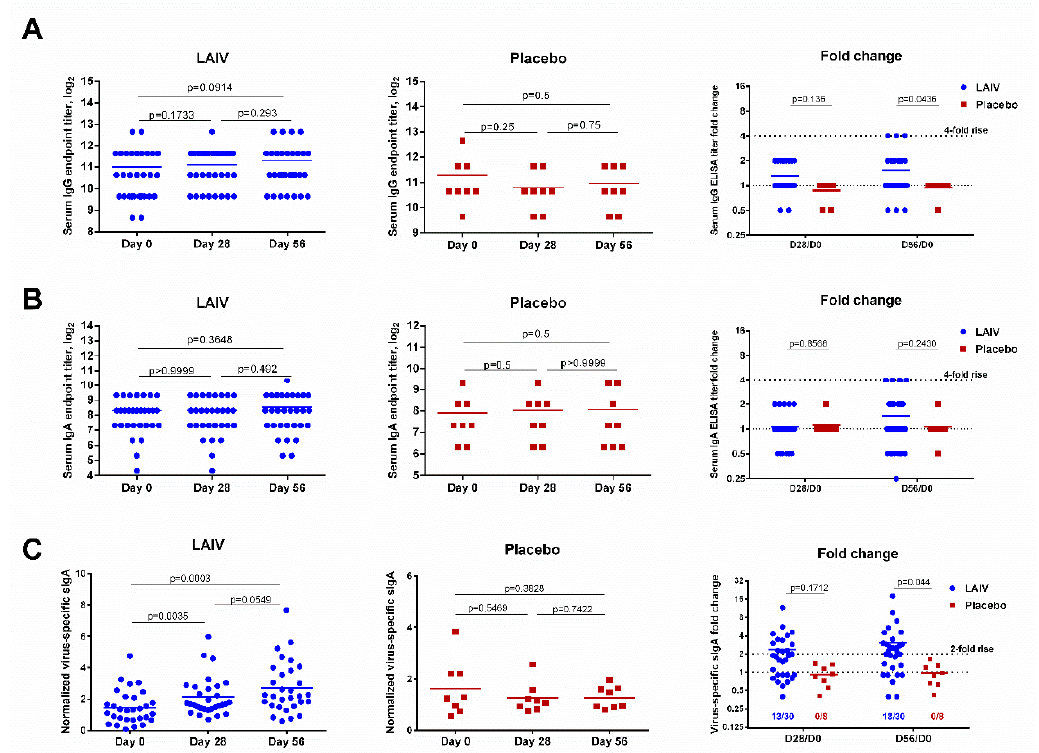
Figure 3. Virus-specific serum IgG and IgA antibody titers and nasal secretory IgA antibody levels in subjects immunized with H7N9 LAIV or placebo. ( A ) Serum IgG titers. ( B ) Serum IgA titers. ( C ) Nasal secretory IgA antibody levels. Data were analyzed by Wilcoxon Matched Pairs Test (left and middle panels) and two-way ANOVA followed by a Bonferroni multiple comparison test (right panel).